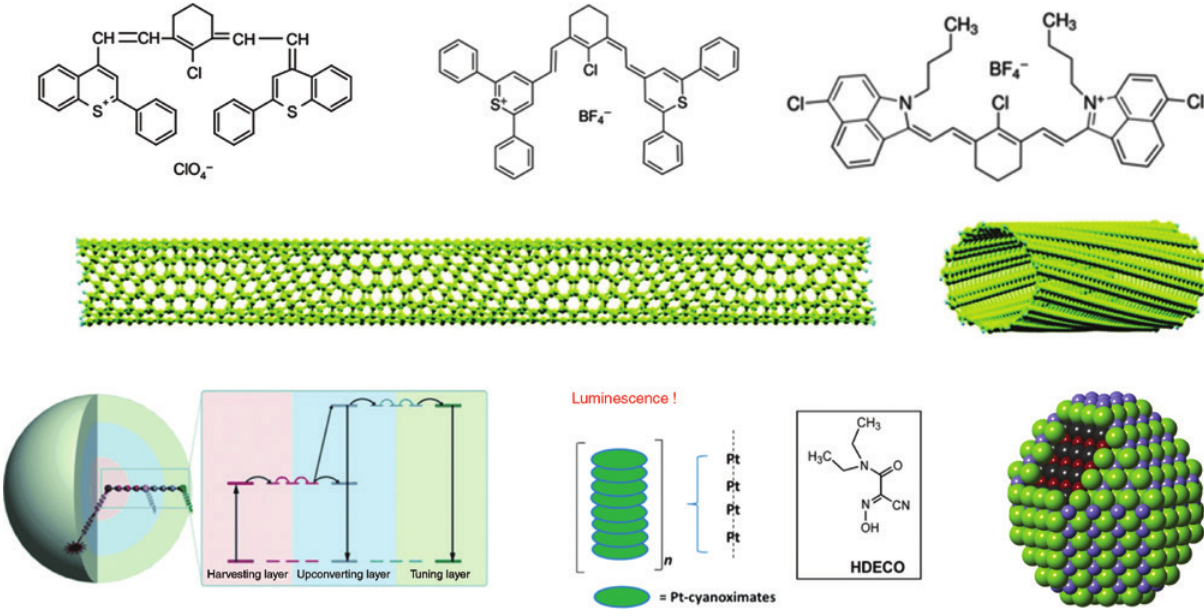
Figure 6: SWIR emitters: commercially available SWIR dyes emitting at > 1000 nm IR-26, IR-1048, IR-1061. Schematics of single-walled carbon nanotubes (with permission from [71]), upconverting nanoparticles (with permission from [72]), nanowire formed by self-assembly of a Pt complex (with permission from [73]), and quantum